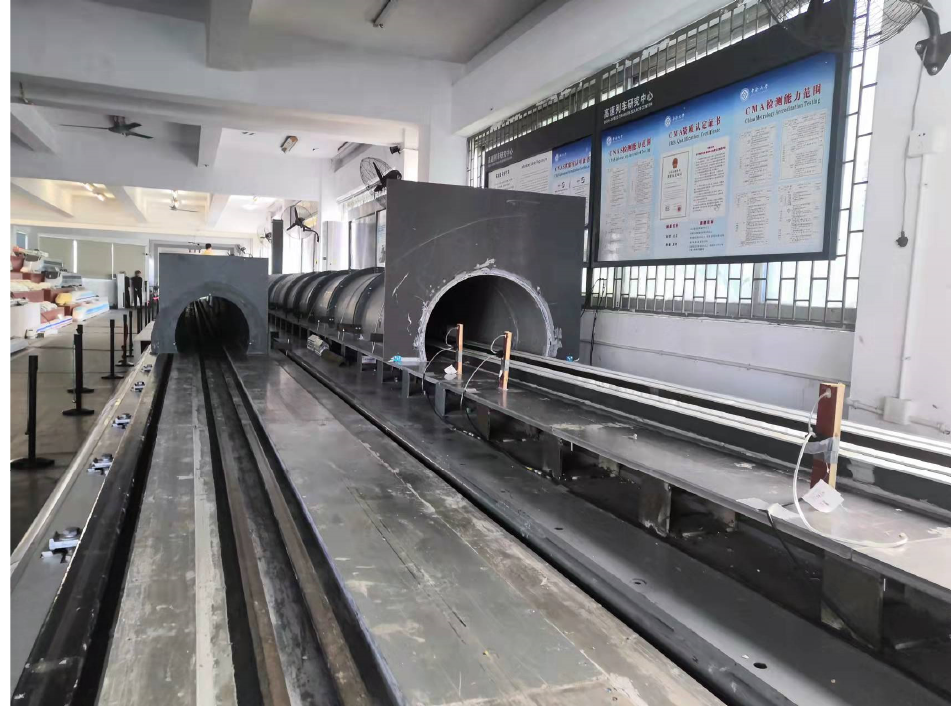
Figure 7. Moving model test site.